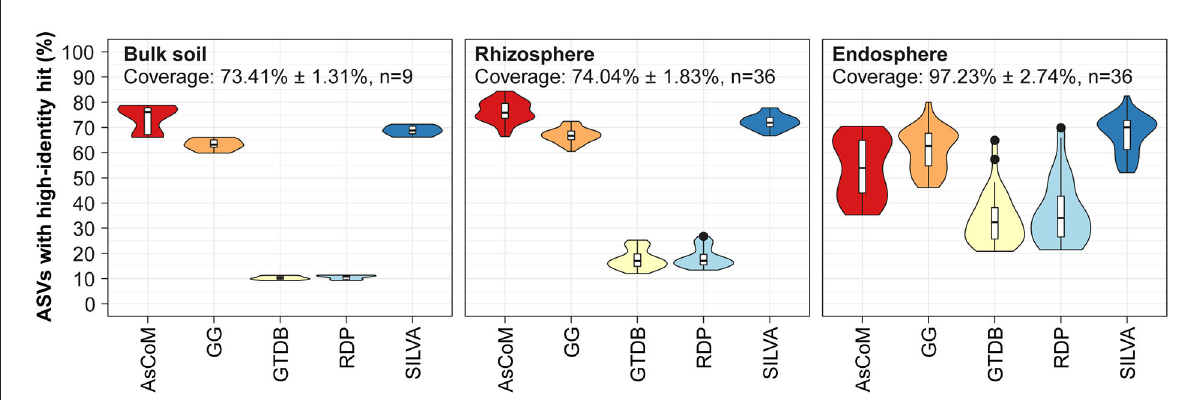
FIGURE2 Database evaluation based on mapping of short-read amplicon data. V5–V7 ASVs obtained from Askov bulk soil as well as rhizosphere and endosphere samples from Lotus japonicus , Medicago truncatula , Hordeum vulgare , and Zea mays were mapped to the following reference databases and the proportion of high-identity hits ( ≥ 99% id) calculated: AsCoM, GreenGenes 16S 13.5 (GG) (Desantis et al., 2006), GTDB release 89 (Parks et al., 2020), RDP 16S v16 (Cole et al., 2014), and SILVA 138.1 SSURef NR99 (Quast et al., 2013). The ASVs were filtered based on